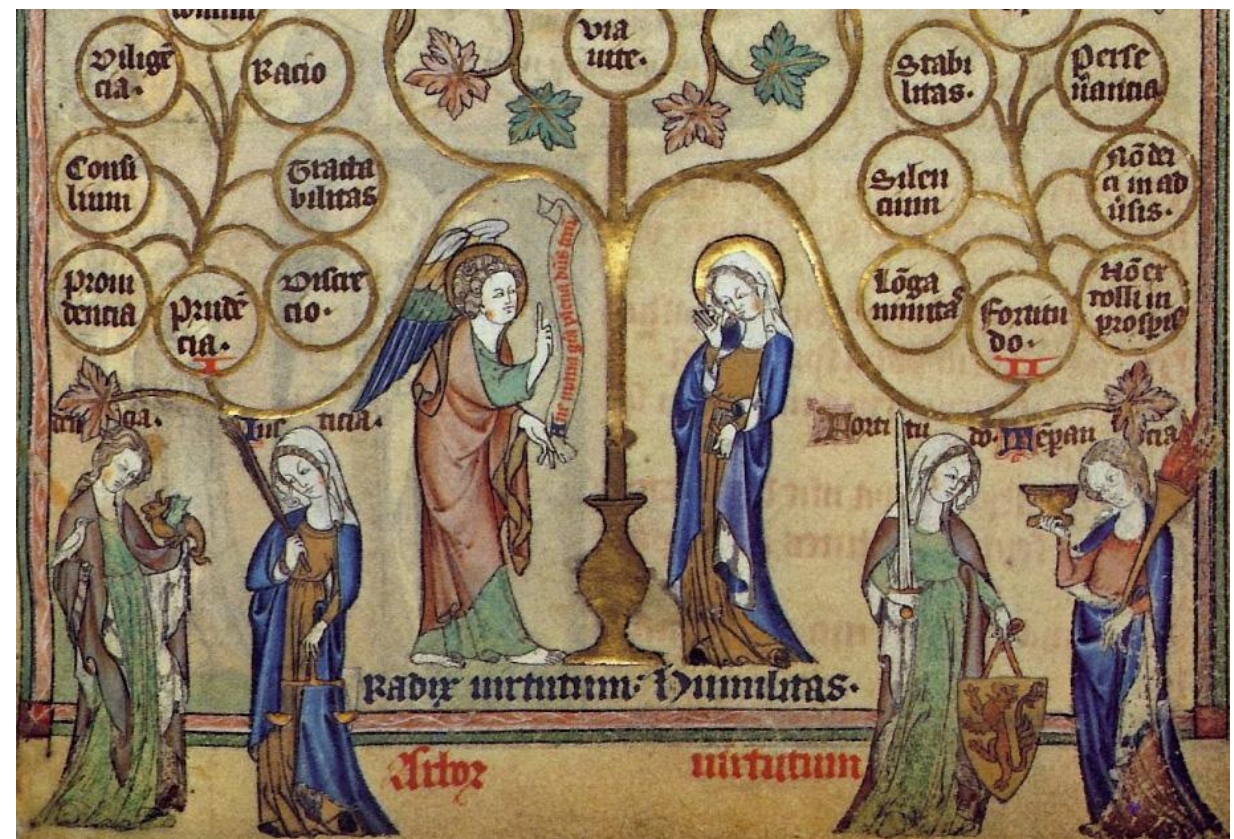
Figure 8. Tree of Virtues, De Lisle Psalter , London, British Museum, Arundel MS. 83 II, fo. 129r (detail).